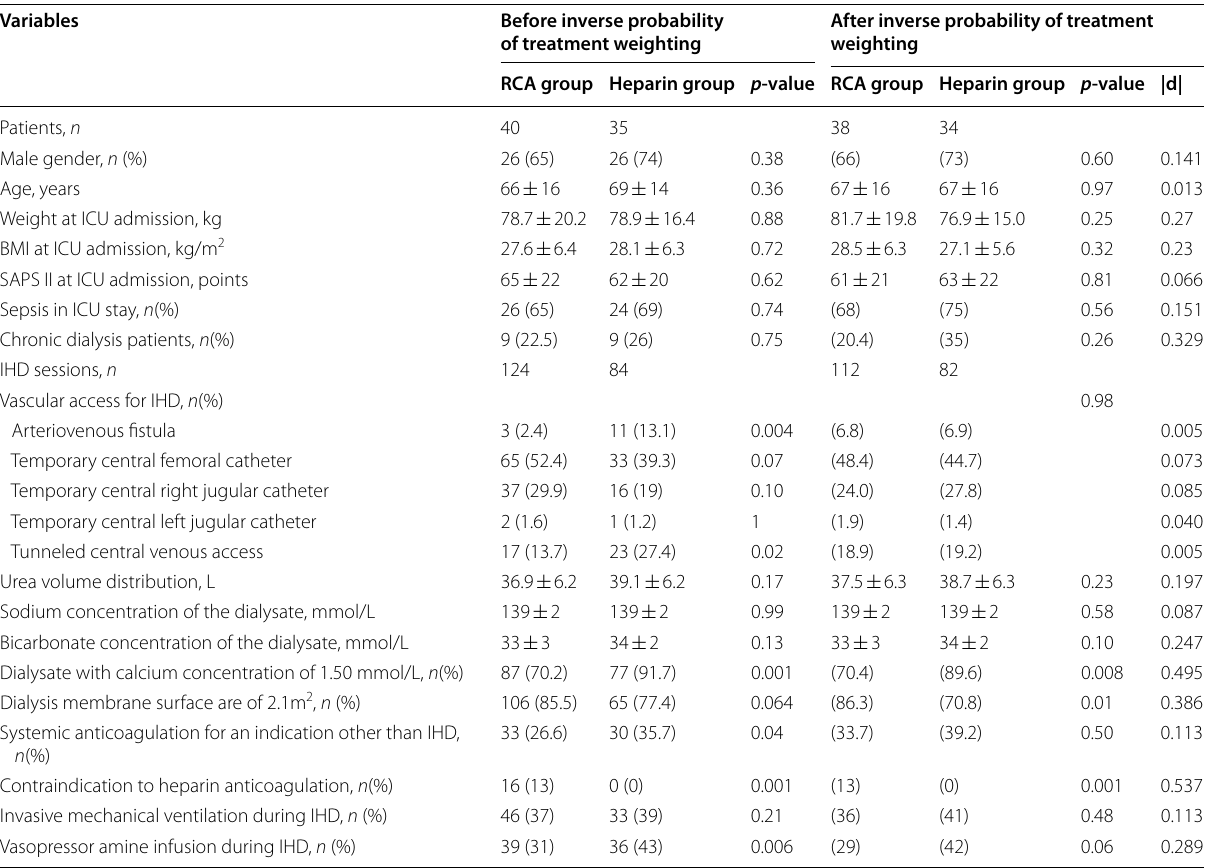
RCA, regional citrate anticoagulation, BMI, body mass index, SAPS, simplified acute physiology score, IHD, intermittent hemodialysis